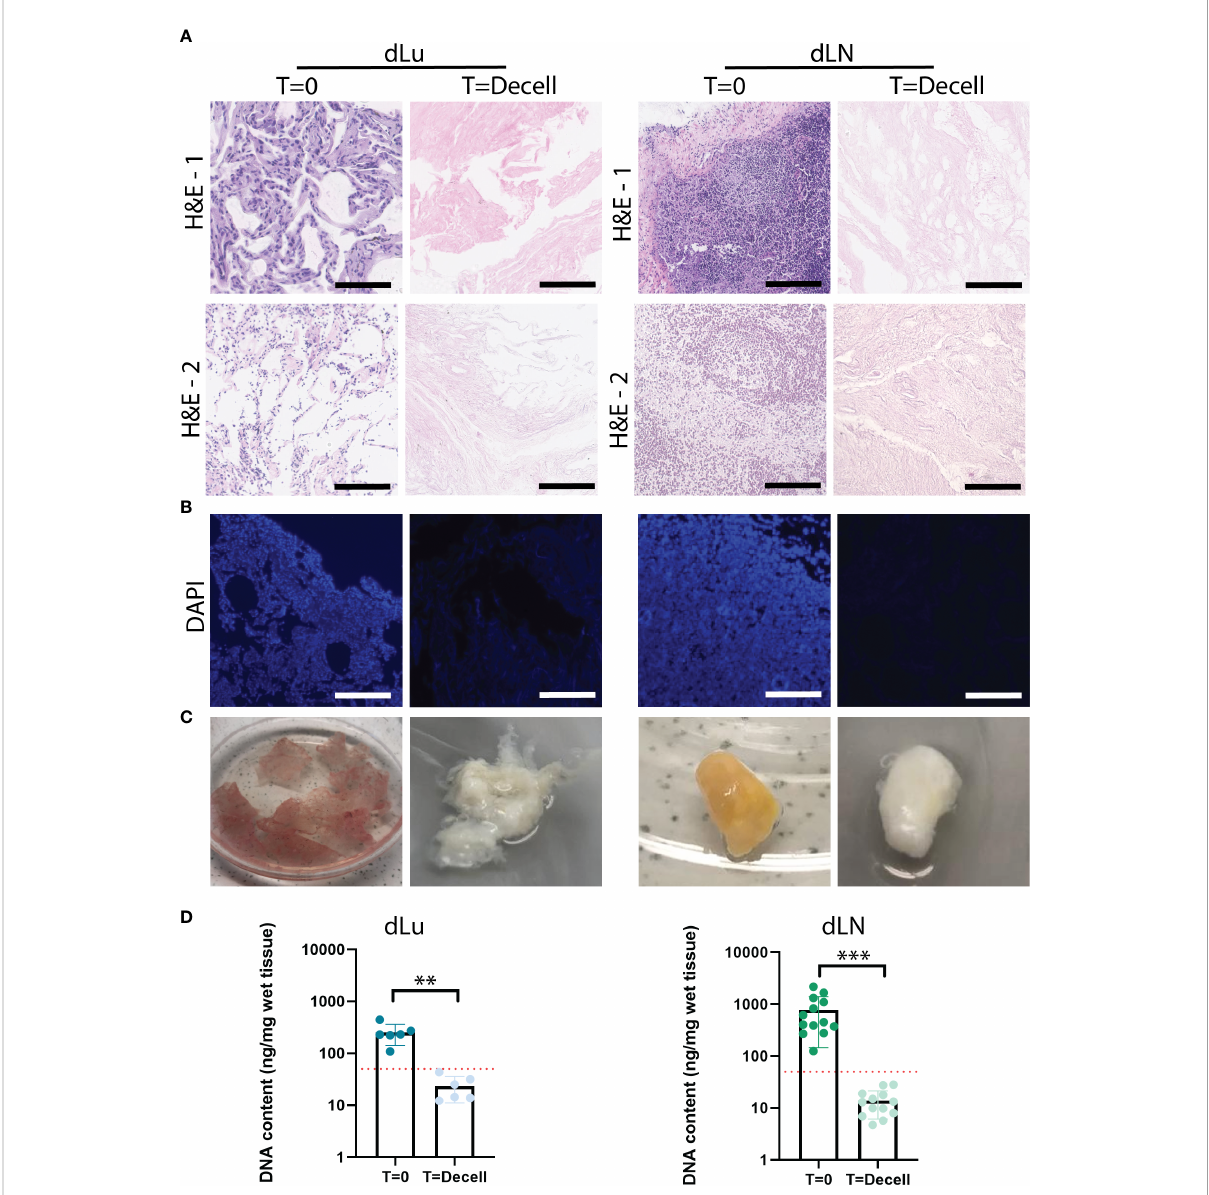
FIGURE 1 Extracellular matrix of lung and lymph nodes obtained by decellularization. (A) Representative H&E stainings of lung and lymph node before (T=0) and after (T=decell) decellularization show ef fi ciently removal of cells from the scaffold and maintenance of ECM structure. Scale bars indicate 200 µ m. 1 and 2 show different donors for dLU (dLu2, dLu3) and dLN (dLN2, dLN12). (B) Representative DAPI stainings of lung (dLu2) and lymph node (dLN6) before and after decellularization con fi rmed removal of nuclear material from the scaffold. Scale bars indicate 250 µ m. (C) Lung slices of 400 µ m thick and an entire lymph node of 0.75 cm thick before and after decellularization, show the transformation in color from brown/yellow to translucent white. (D) Quantitative DNA content analysis of lung (n=3 patients, with each patient measured in technical duplicate, p=0.003) and lymph node (n=13, p=0.0002) before and after decellularization con fi rms successful decellularization. Error bars indicate ± SD. ** = p-value < 0.005, *** = p-value < 0.001. Paired t-tests were used for determining signi fi cance in DNA content. The red dotted line indicates a threshold of 50 ng DNA/mg wet tissue, which is a common criteria for adequate cell removal (29). For the DNA content dLu1-3 and dLN1-13 were used.